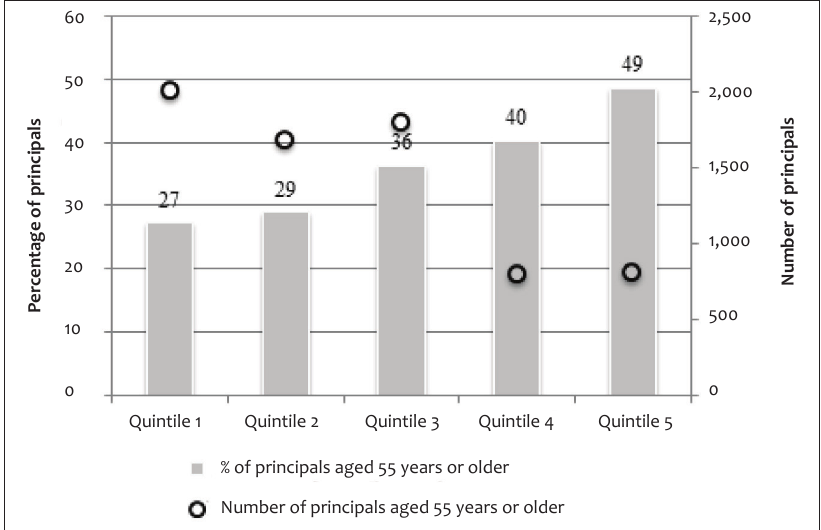
Figure 2: Incumbent school principals in 2012 aged 55 years or older by school quintile Source: Persal-EMIS matched dataset, own calculations. Notes: See Figure